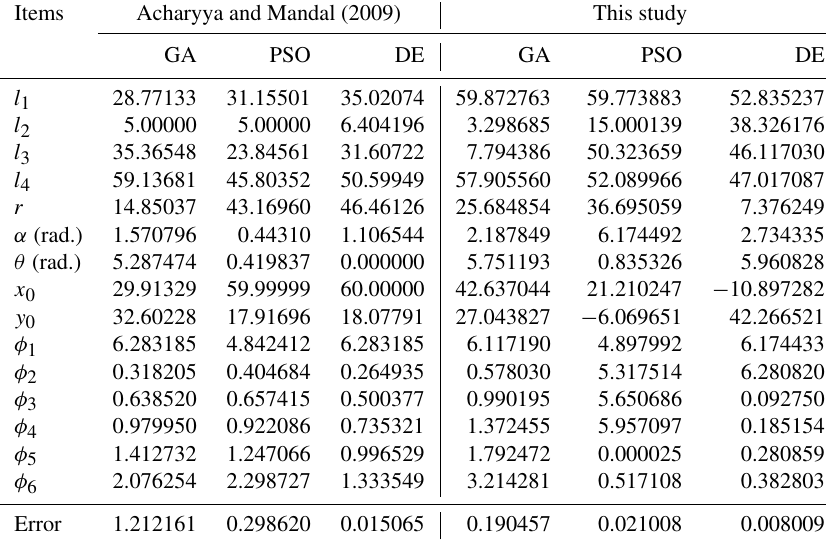
Table 1. Linkage solutions and structural errors obtained in previous work and in this study for Example